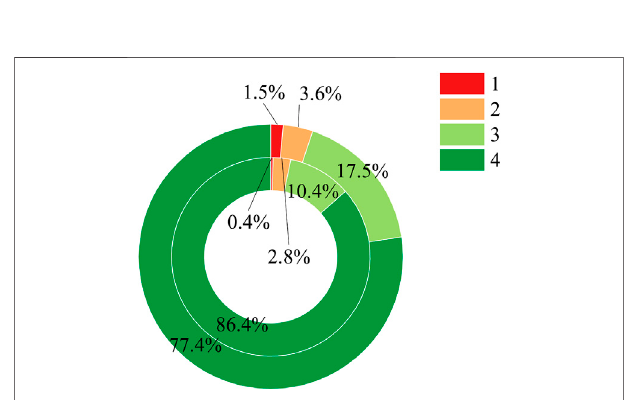
FIGURE 8 | Percentage of each level. The inner and outer circles representthe manually drawnand predicted pollution distribution maps in this study, respectively. The numbers (1 – 4) represent the polluted